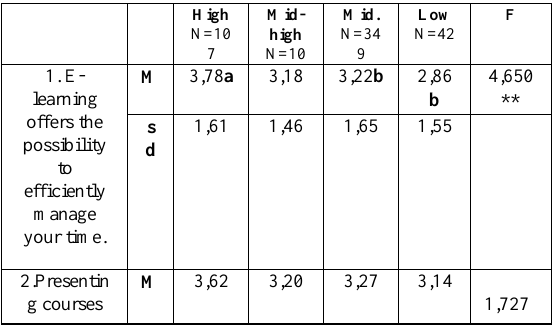
Table 7.Anova results for Economic Status of